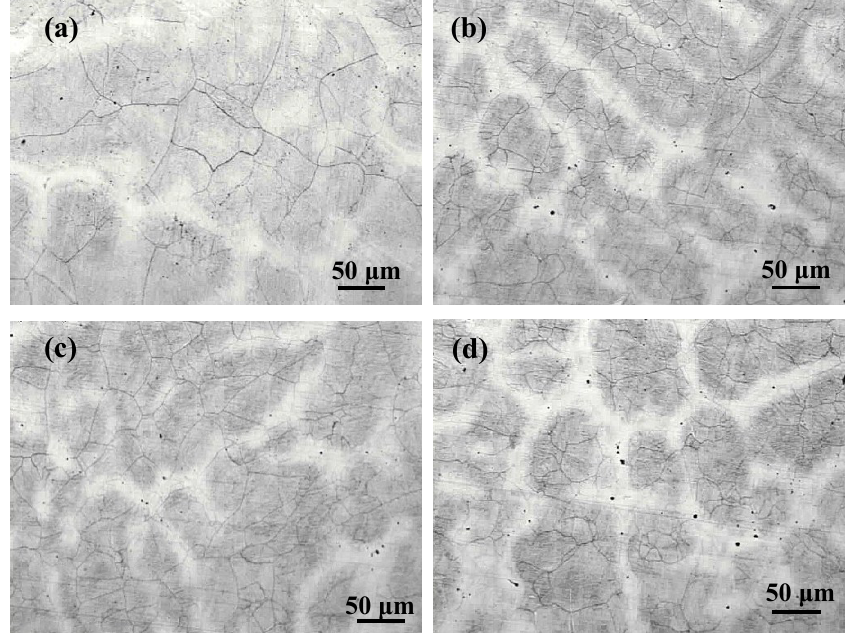
Figure 1. The grain size of casted steels with different contents of REM ( a ) 1# ingot without REM; ( b ) 2# ingot with 0.015% REM; ( c ) 3# ingot with 0.025% REM; ( d ) 4# ingot with 0.1%